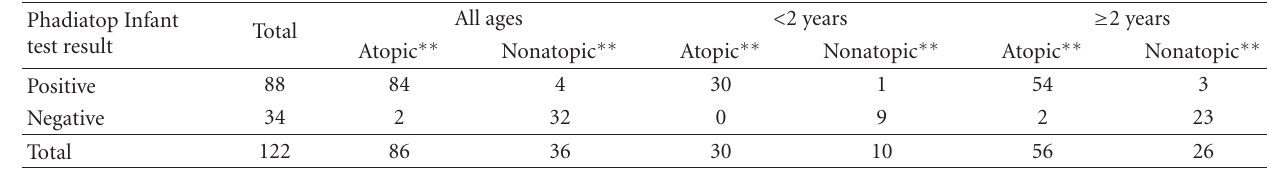
Table 2: Diagnostic performance characteristics of Phadiatop Infant. Data are given as number of